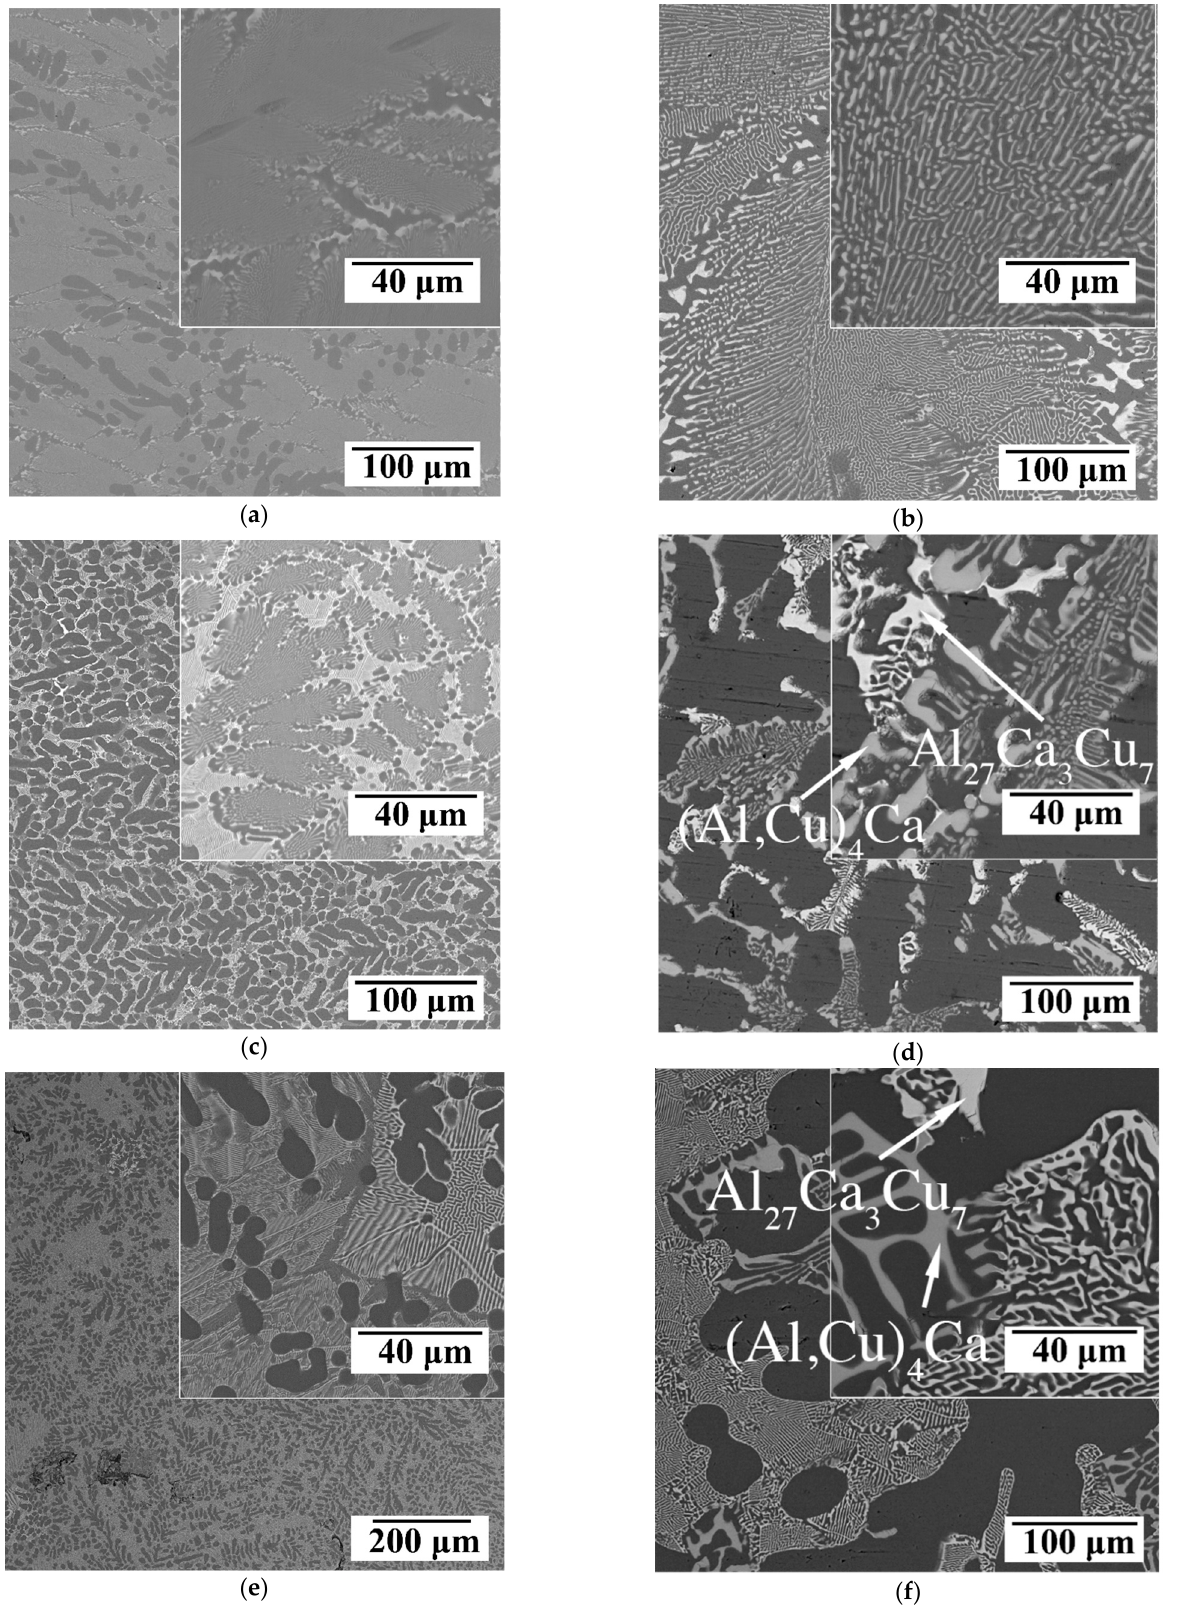
Figure 6. SEM microstructure of the alloys: ( a , b ) Al3.4Cu5.6Ca, ( c , d ) Al5.6Cu3.5Ca, ( e , f ) Al9.0Cu3.5Ca for cooling rates of ( a , c , e ) 10 K/s and ( b , d , f ) 0.02 K/s. BSE.